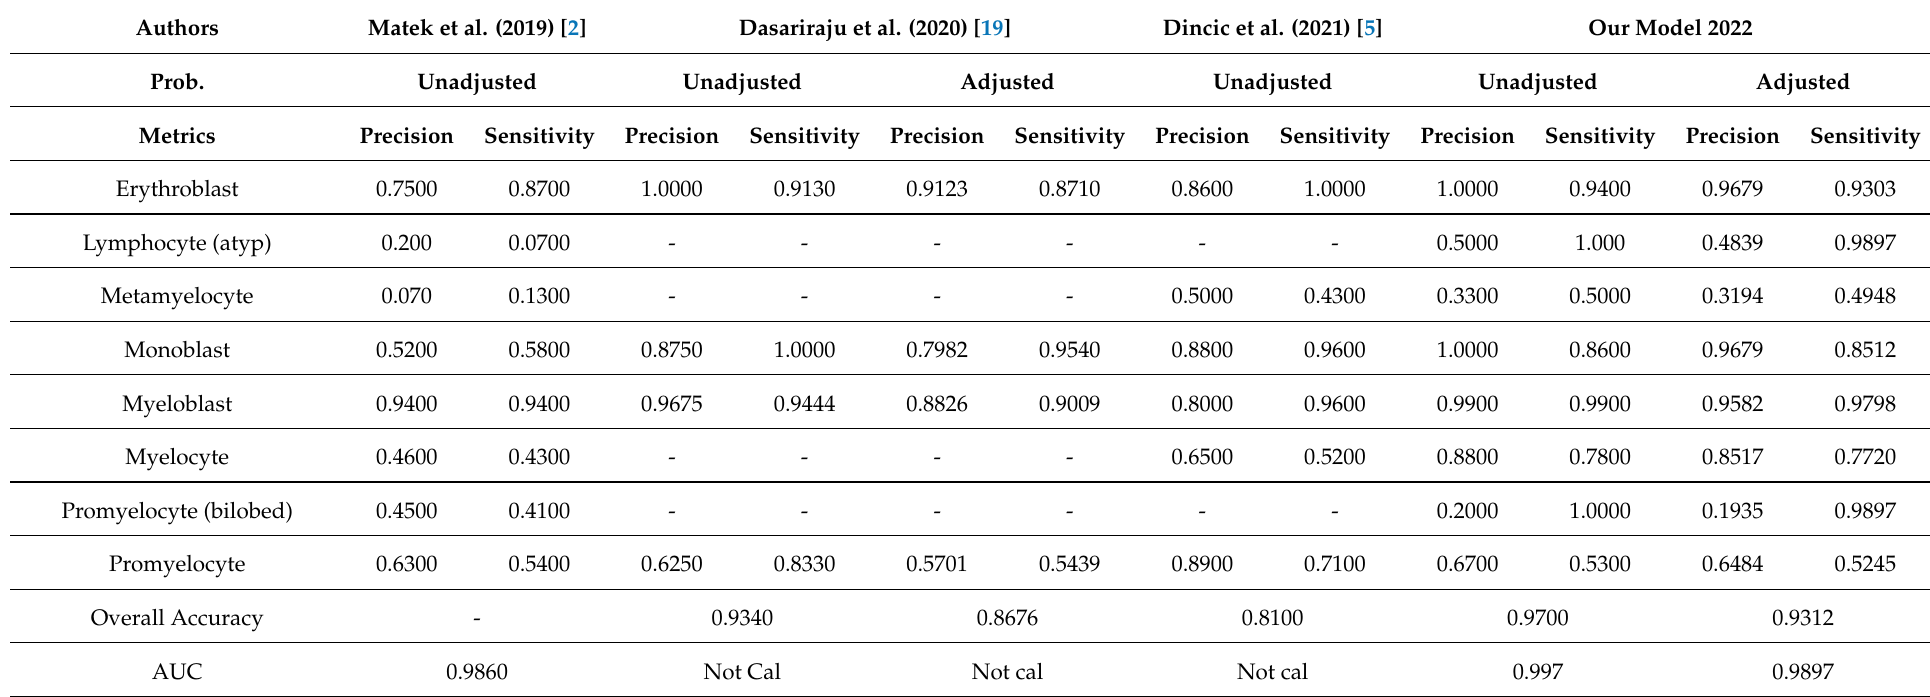
Table 5. Comparison with other